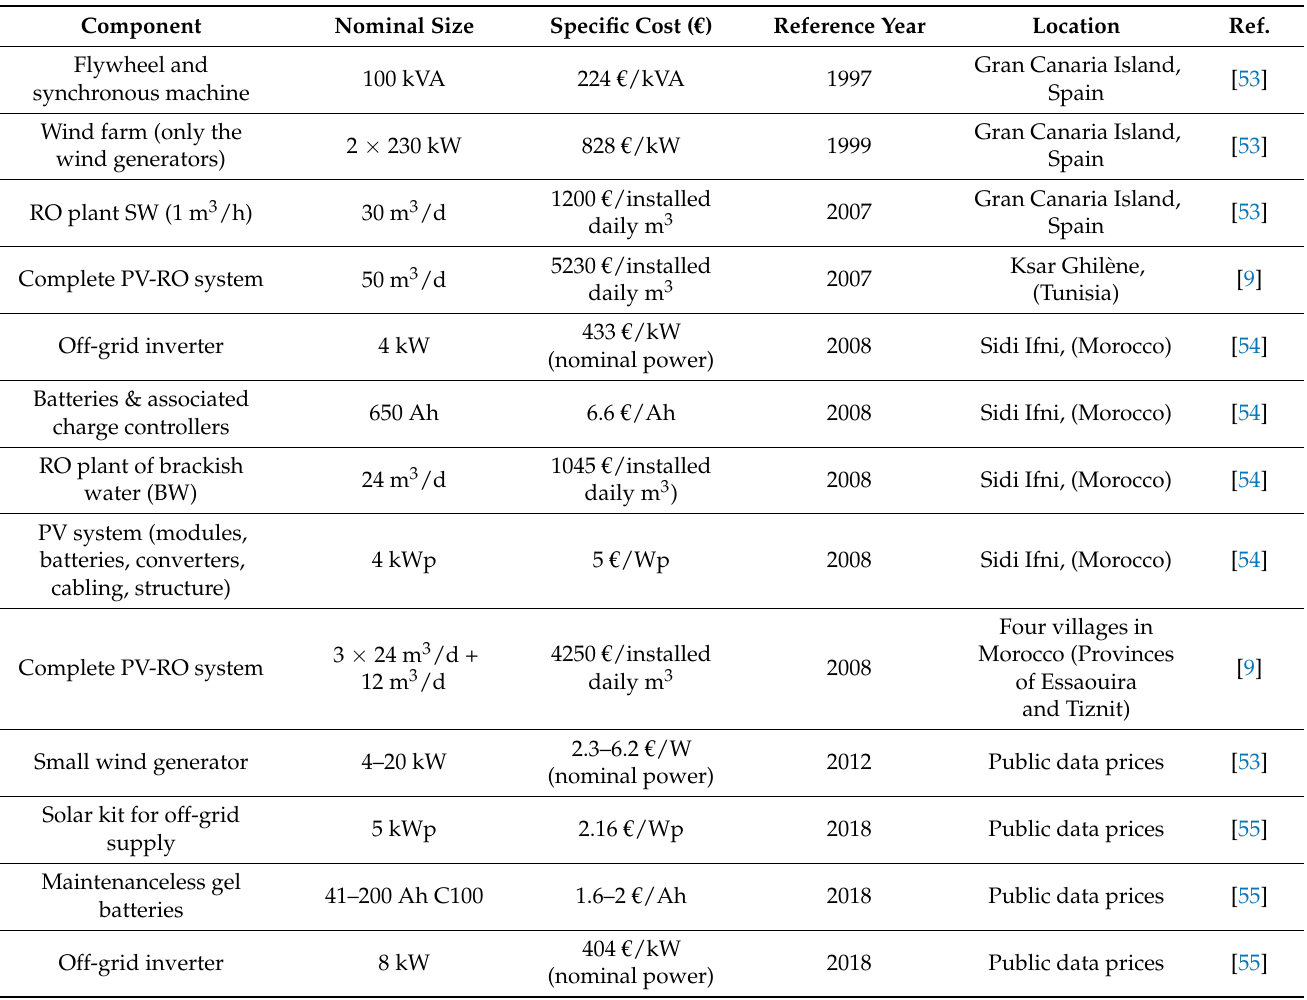
Table 12. Capital costs of different components (purchased systems).